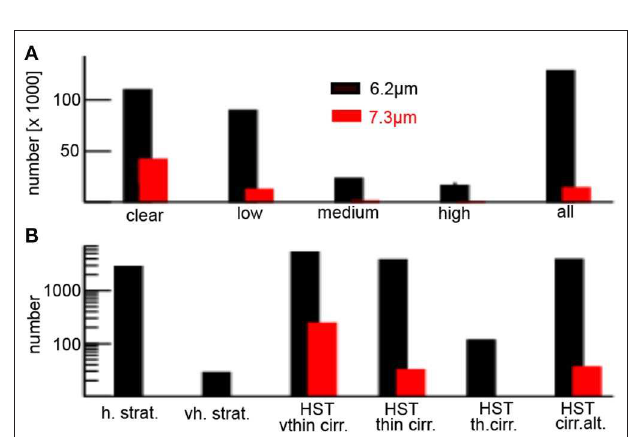
FIGURE 5 | Histogram of NWC-SAF cloud types in zero-cloud impact (ZCI) data in summer period 2016, see section 2.4 for definitions and abbreviations. (A) All cloud types, (B) high